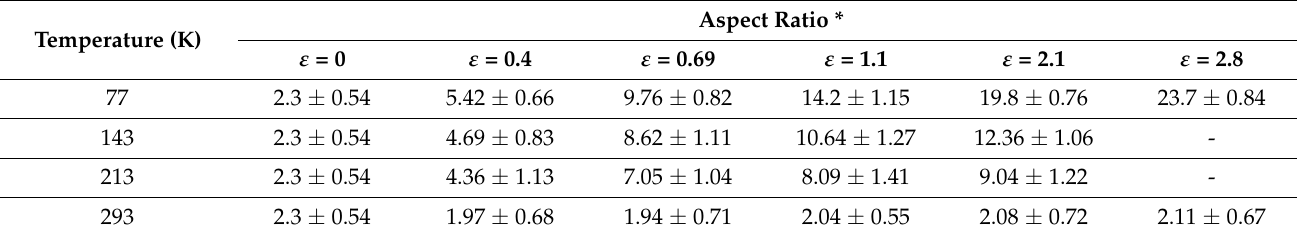
Table 1. Grain aspect ratio after PSC as a function of temperature and strain.